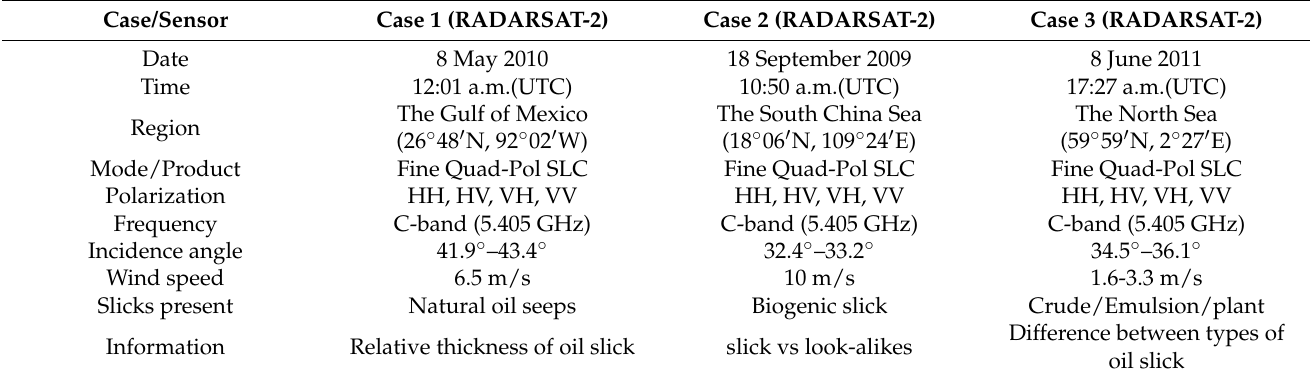
Table 2. Properties and descriptions of the three SAR scenes used in this